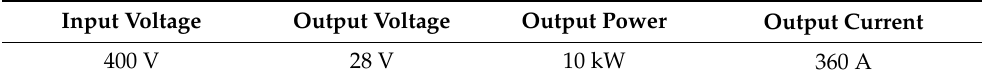
Table 1. Isolated DC/DC converter specification.